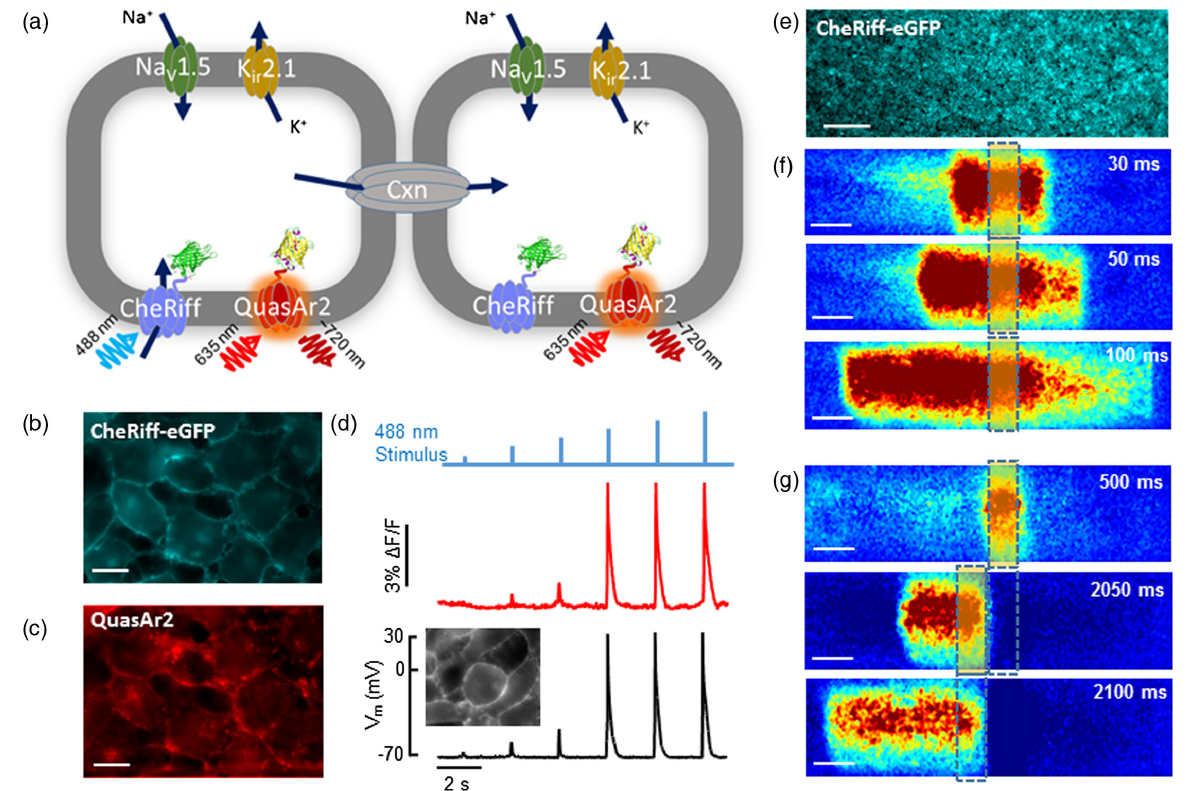
FIG. 1. Optopatch spiking HEK (OS-HEK) cells enable optical stimulation and optical readout of electrical waves in confluent monolayers. (a) Functional components of OS-HEK cells. Two transgenic ion channels (Na V 1 . 5 , K to produce electrical spikes. Two optogenetic components (CheRiff and QuasAr2) provide optical input and output, respectively. Endogenous gap junctions provide electrical coupling between neighboring cells. (b) Image of eGFP fluorescence in CheRiff-eGFP. (c) Image of QuasAr2 fluorescence. Scale bars in (b) and (c) 20 μ m. (d) Simultaneous fluorescence recording (red, λ 1 kW = cm 2 , λ ¼ 668 – 743 nm) and patch clamp measurements (black) during ramped optogenetic stimulation (blue). Inset: Image of em the recorded cell. (e) Wide-field image of eGFP fluorescence in a confluent layer of OS-HEK cells. (f) Images of QuasAr2 fluorescence showing wave propagation induced by a flash of blue light delivered to the dashed box. (g) Directional waves are launched by inactivating a zone (top) and then stimulating an adjacent region (middle). Scale bars in (e) – (g) 500 μ m. See Movie 2 in Supplemental Material